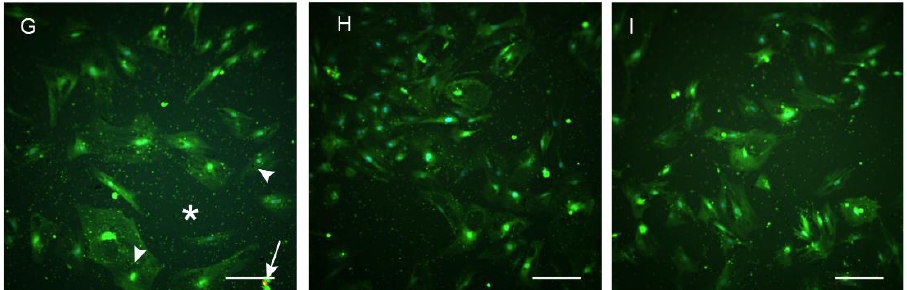
Figure 8. Images from the Live/Dead assays. Adipose-derived stromal cells not incubated with Laser ablated Albumin functionalized AuNPs (LA-AuNPs) (( A ), control), exposed for 24 h to 2 nm LA-AuNPs ( B – E ), and 53 nm LA-AuNPs ( F – I ), in the dilutions 1:1 ( B , F ), 1:2 ( C , G ), 1:5 ( D , H ), and 1:10 ( E , I ). Fluorescent labeling of viable cells with calcein (green), dead cells marked with Eth-1 (red, arrows in ( B , F )), and nuclei marked with Hoechst (blue). Nanoparticles detected as fine dispersion on well surface (asterisk), and cellular uptake observed as black clusters in the cytoplasm (arrowhead). Objective 20 × , scale bars 200 µ m.